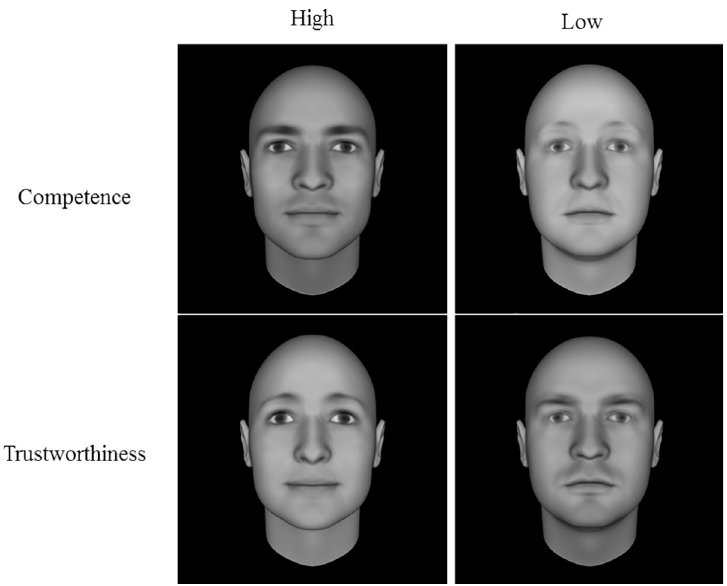
Fig 1. Computer generated face stimuli. All stimuli were created using Face Gen 3.1 and taken from publicly available sets of Original Computer Generated Faces, Oosterhof and Todorov [1].